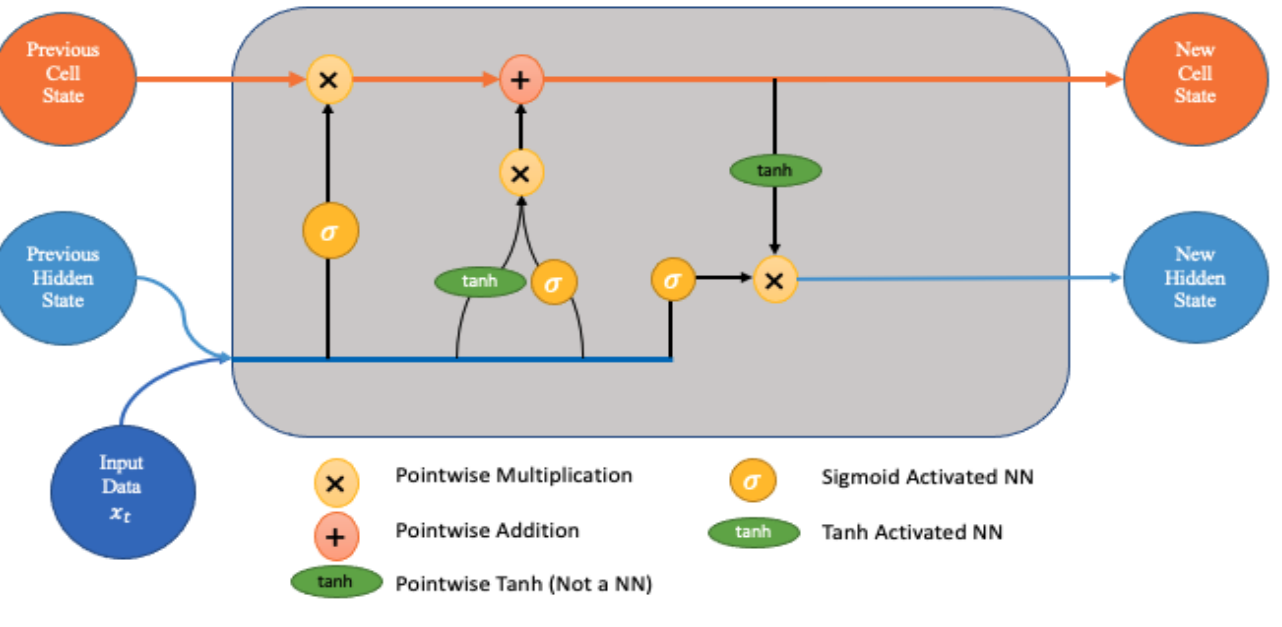
Figure 4. LSTM Figure 4. LSTM structure.